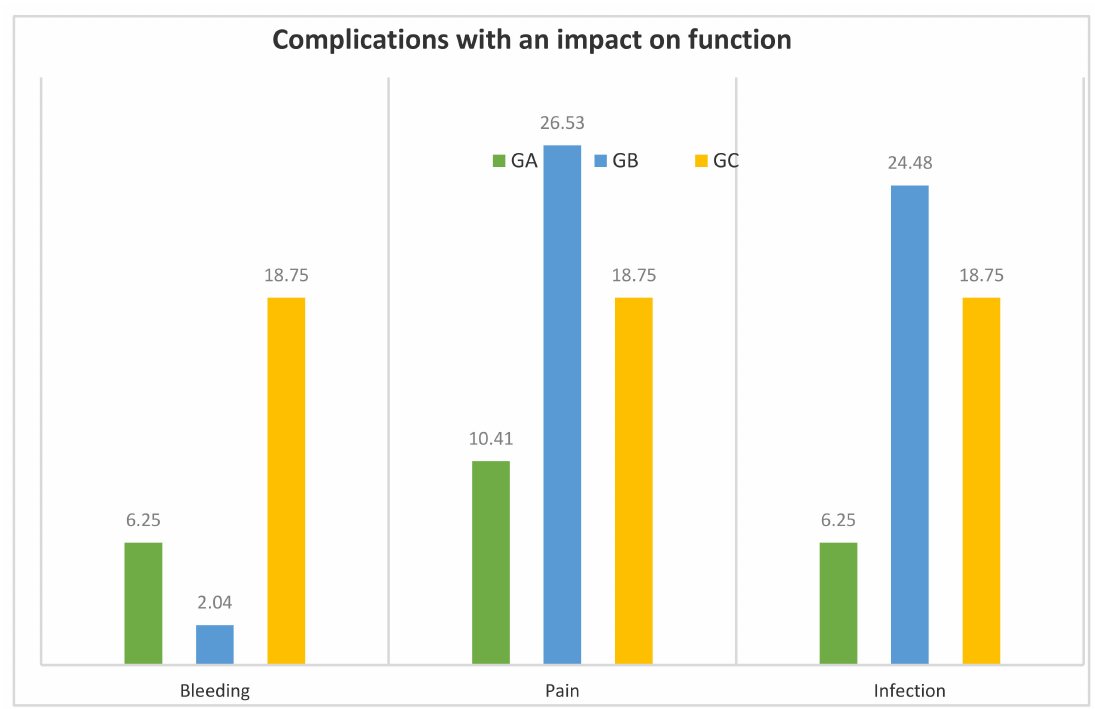
Figure 2. Complications with an impact on function (% of women who showed some sign or symptom requiring medical attention) in GA, GB and GC. GA: patients with anaesthetic risk ASA I. GB: patients with anaesthetic risk ASA II. GC: patients with anaesthetic risk ASA